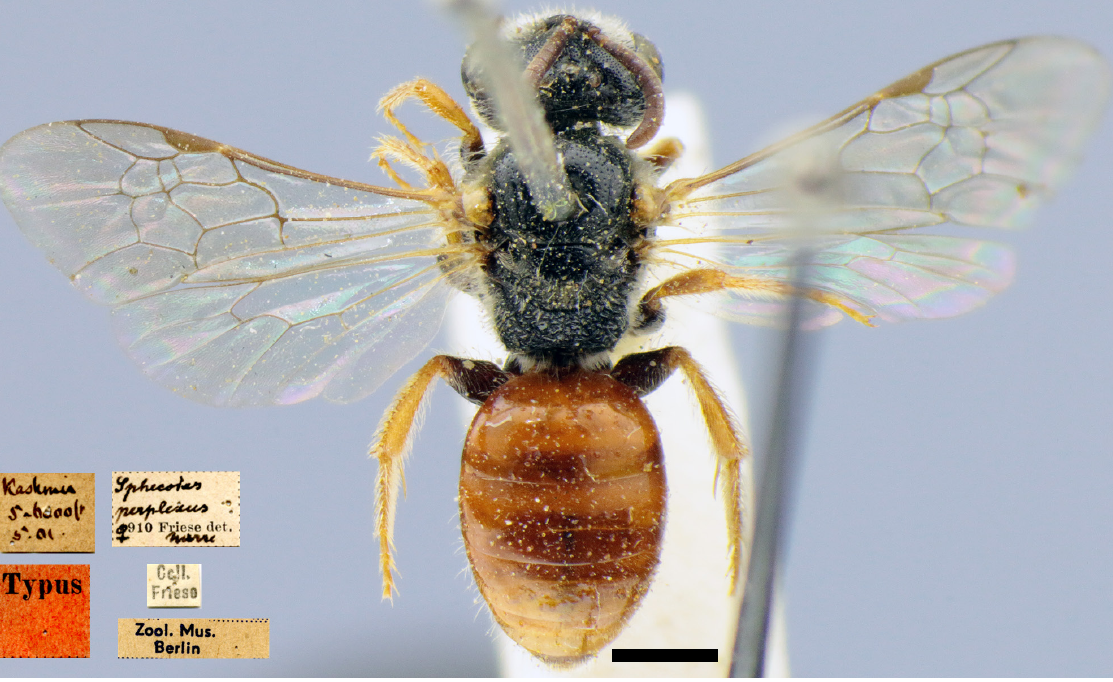
Fig. 14. Sphecodes perplexus Nurse, 1903. Syntype, ♀ (ZMHB). Habitus in dorsal view and labels. Scale bar = 1